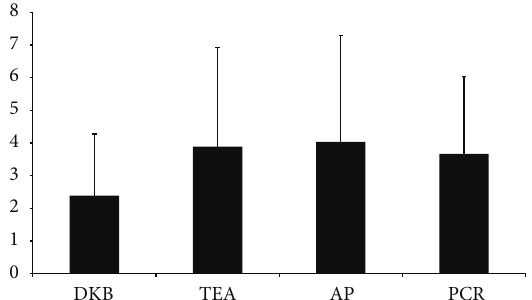
Figure 6: Mean deviations (in degrees) and standard errors obtained from CT-determined aTEA for each method.